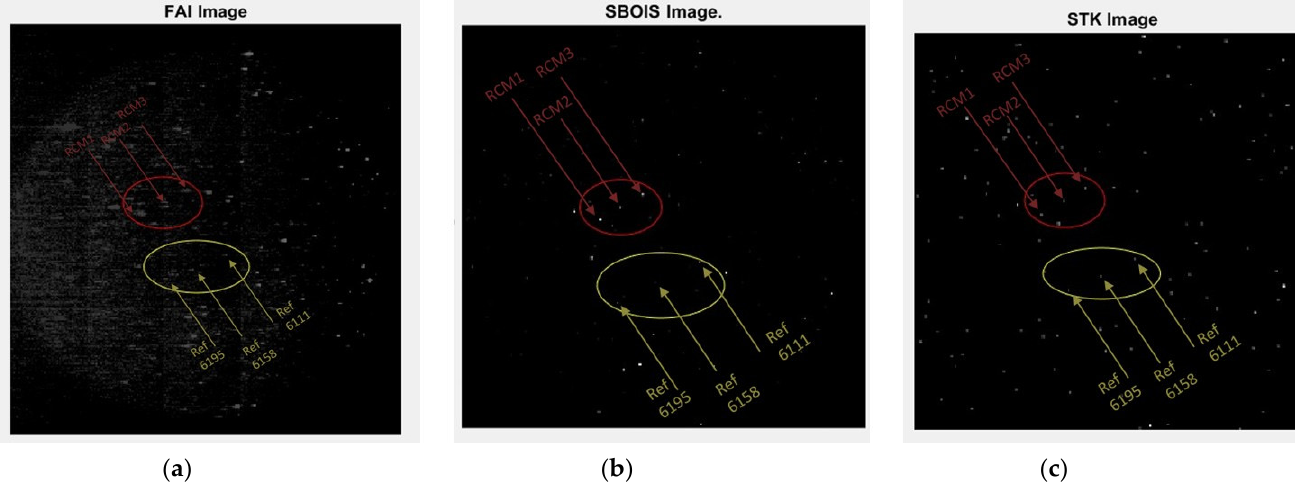
Figure 3. Sample Images from: ( a ) FAI on-orbit observation (left) [15]; ( b ) Simulated using SBOIS (center); ( c ) Simulated using STK-EOIR (right).